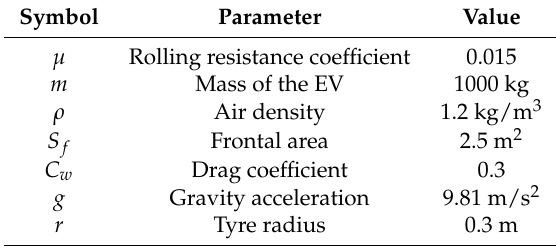
Table 2. EV Parameters.